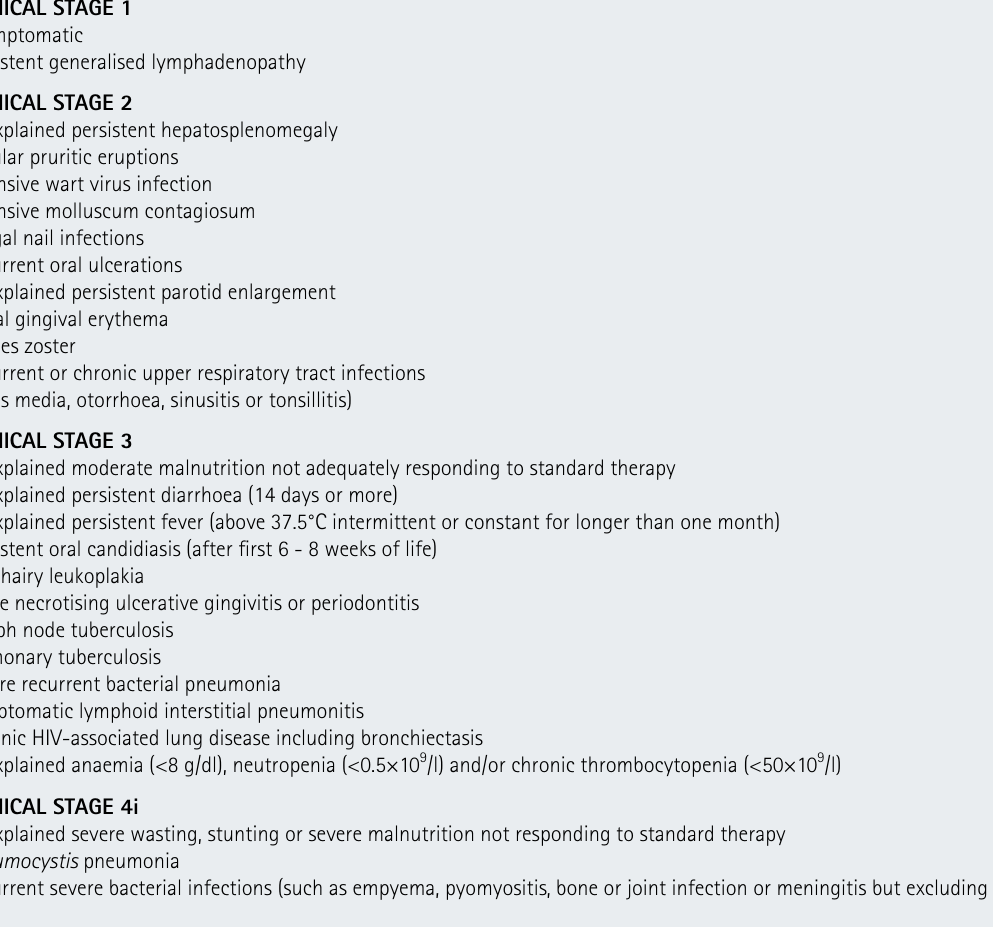
TABLE I. WHO CLINICAL STAGING OF HIV/AIDS FOR CHILDREN WITH CONFIRMED HIV